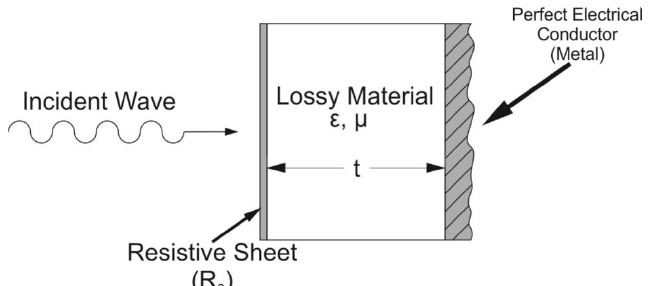
Figure 3. Schematic of the Salisbury configuration: the metallic plane (perfect electrical conductor) reflects the wave transmitted in the lossy slab (white) and strapped thanks to the resistive sheet [26]. The lossy material is set with a thickness of λ of the aimed 4